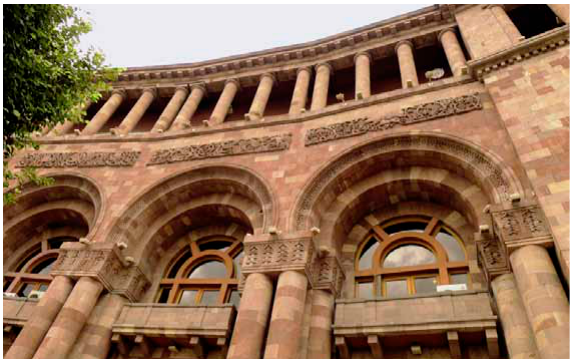
fig. 17. The decor of the Palace of the Yerevan Government in republic Square. r. Čepaitienė photo